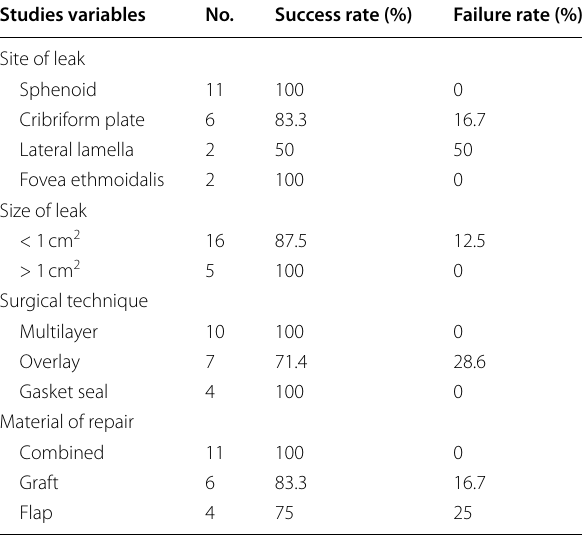
Table 1 Illustrate the success and failure rate according site, size of leak, surgical technique, and material of repair